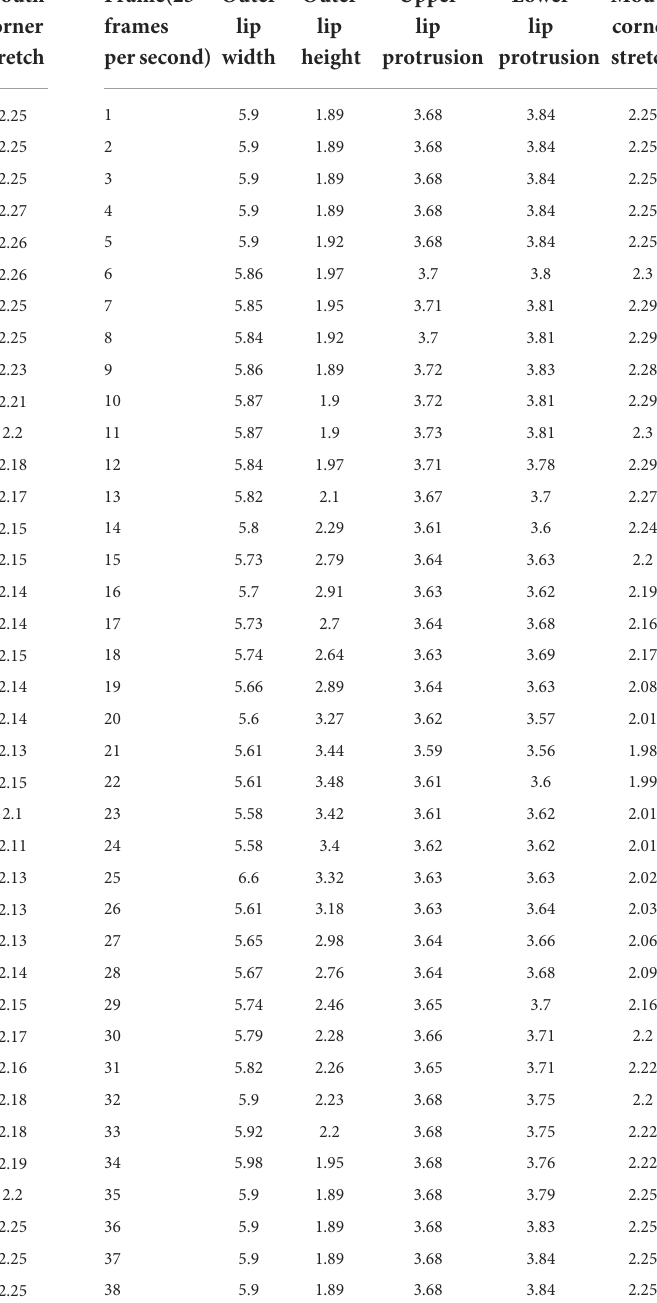
TABLE 3 The dynamic data value of each part of “ ”/p h a/ in the Tibetan Xiahe dialect (unit: cm). Frame(25